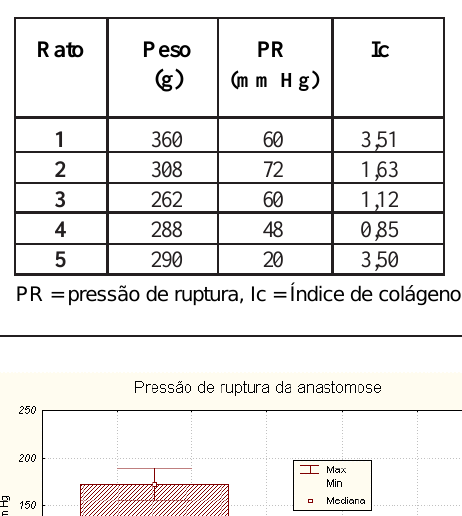
TABELA 2 – Dados obtidos no grupo I+An.